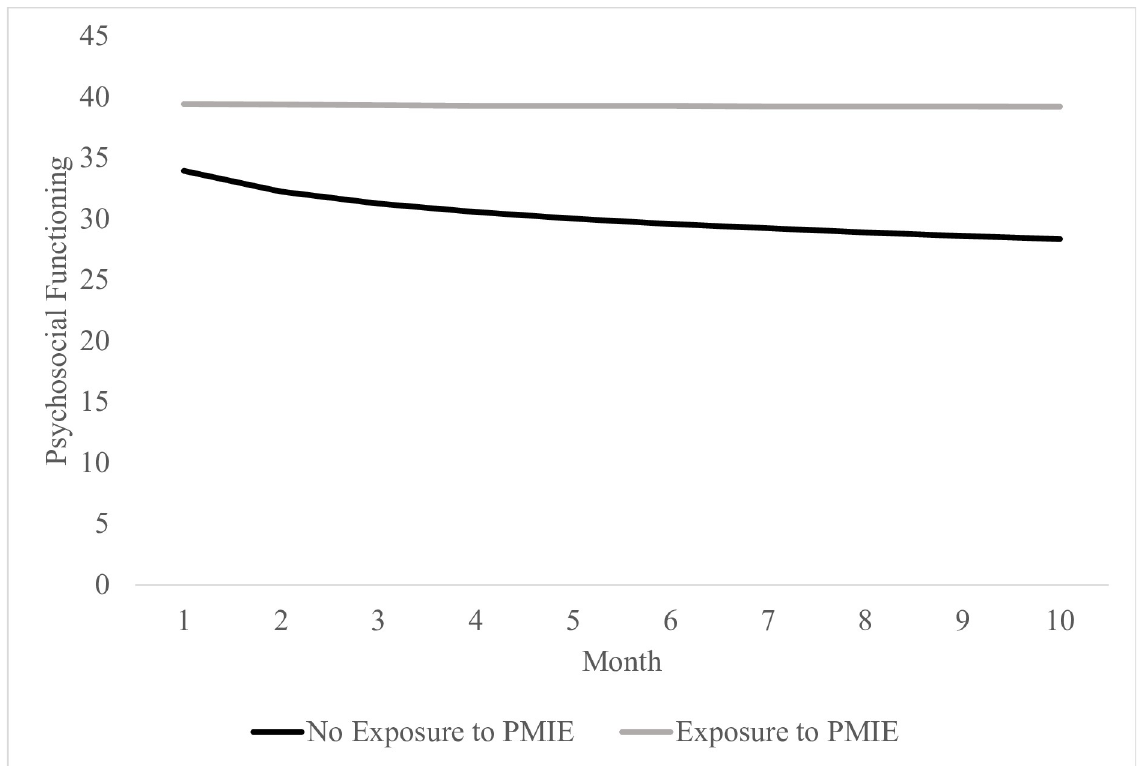
Fig 1. Logarithmic change in psychosocial functioning over the course of 10 months during the COVID-19 pandemic based on PMIE exposure.